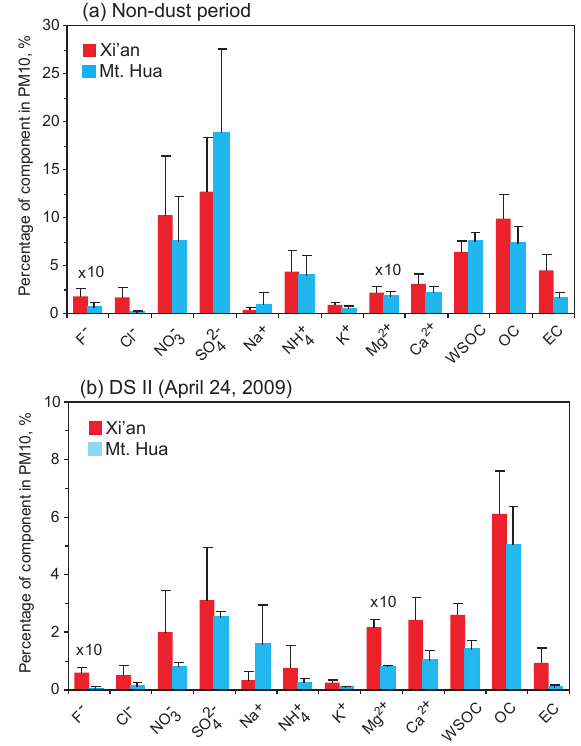
Fig. 7. Relative abundances of components of PM 10 from Xi’an and Mt. Hua during (a) the non-dust storm and (b) the dust storm